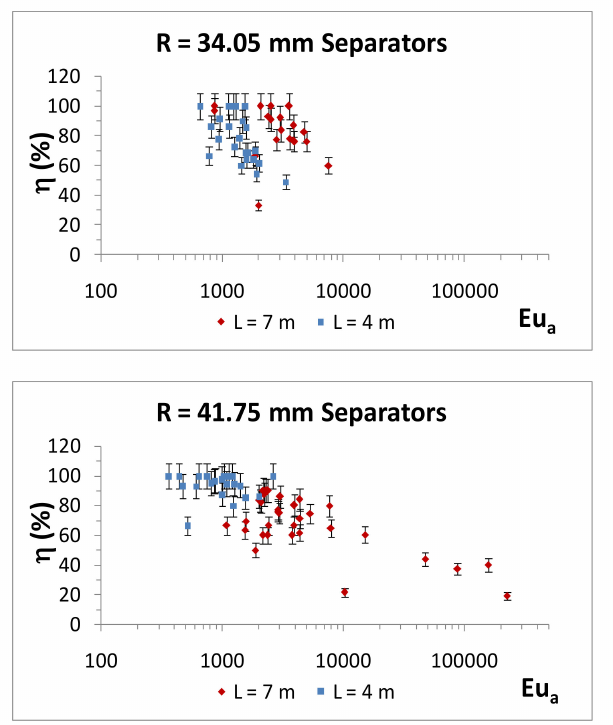
Figure 15. Relationship between apparent Euler number Eu a and η (%) for the separators tested with different helix radiuses R (34.05 mm and 41.75 mm) and tube lengths L (4 and 7 m).